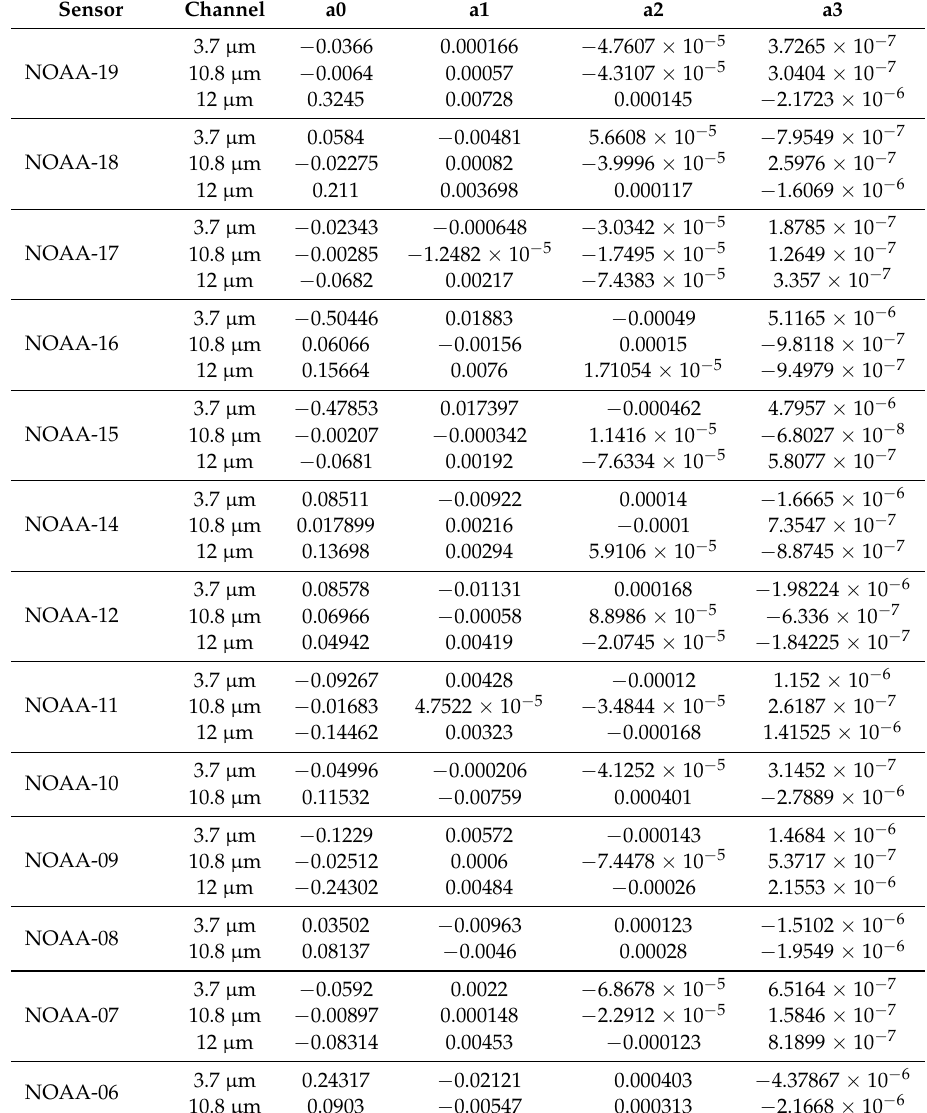
Table 5. Cubic coefficients for AVHRR MetOp-A minus AVHRR sensor differences simulated using RTTOV v11.3 for an atmospheric path length of 1.8. Coeffiecients are a function of total column water